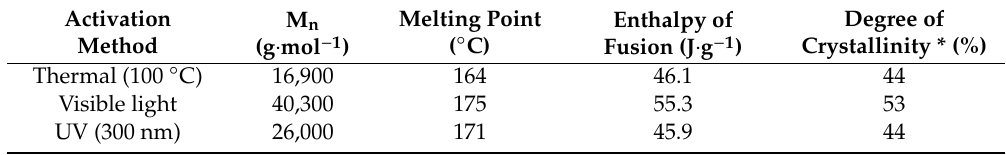
Figure 6. DSC thermograms of PVDFs synthesized in the presence of complex 1 after a 24 h-reaction with different activation methods. Table 3. Molar masses and thermal characteristics of PVDFs obtained by polymerization of VDF in the presence of complex 1 from different activation methods.